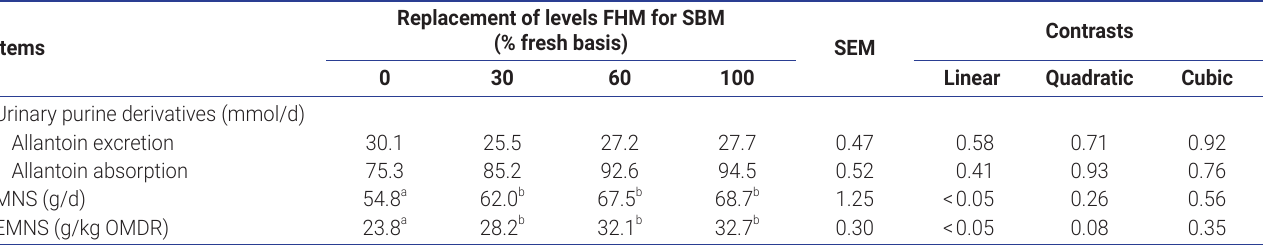
Table 4. Flemingia as a protein source fodder on urinary purine derivatives and microbial protein synthesis in beef cattle